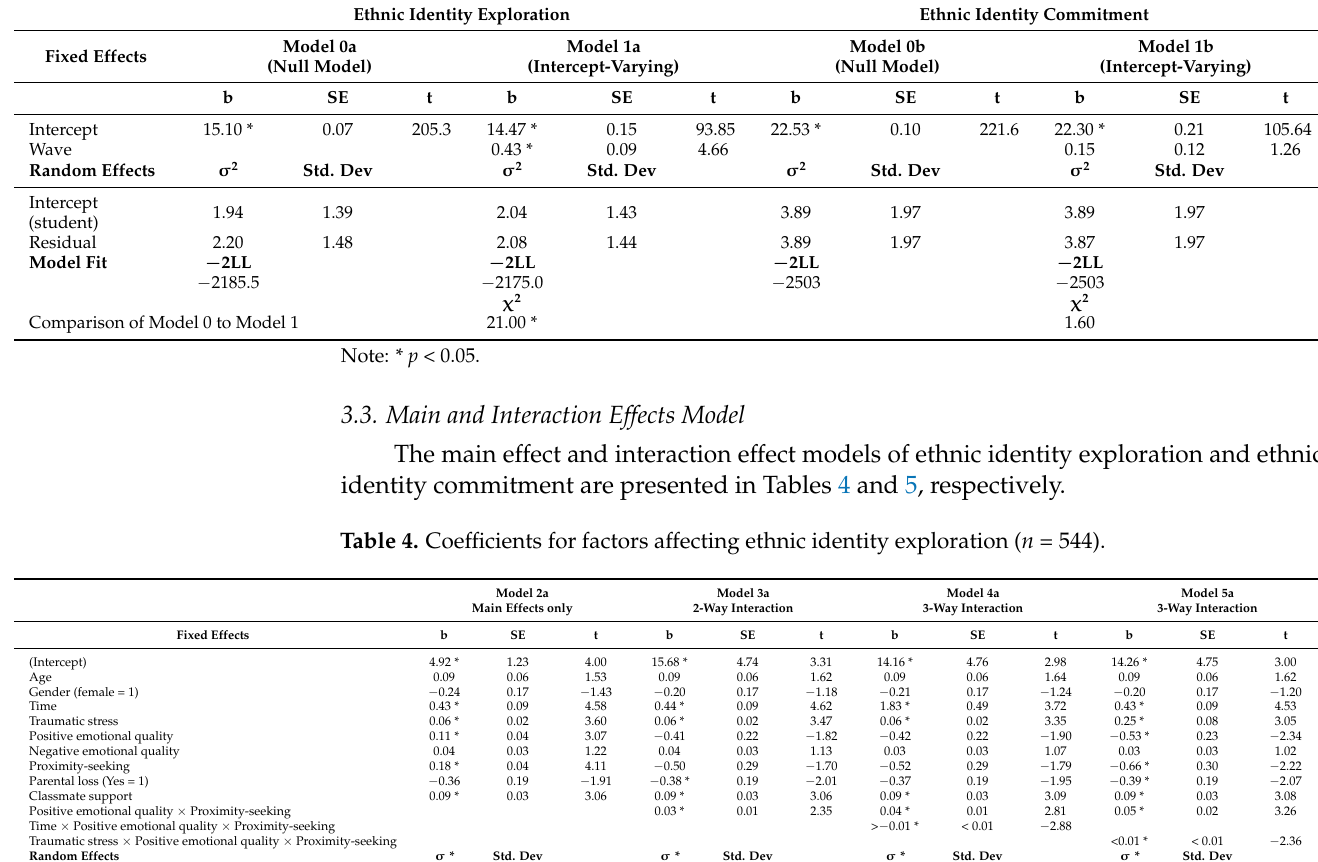
Table 3. Multilevel models of ethnic identity exploration and commitment over time.